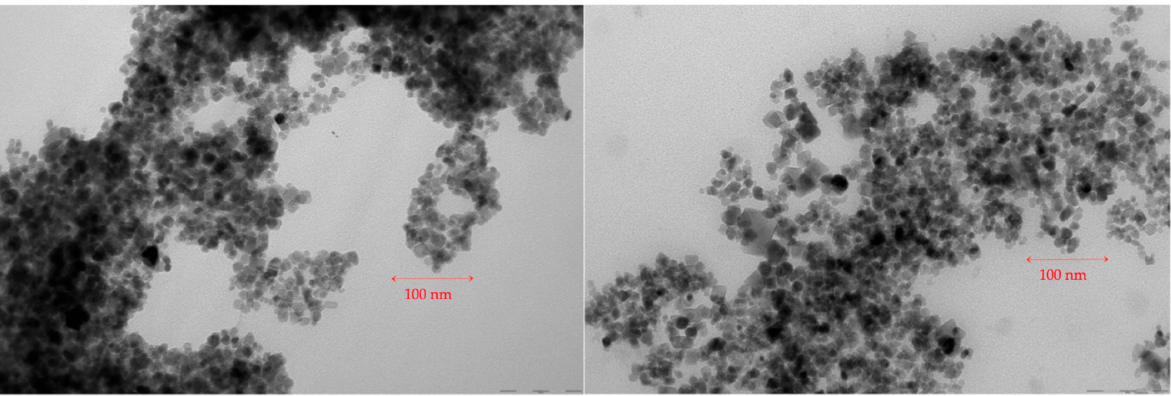
Figure 2. TEM micrographs of PTX-MN